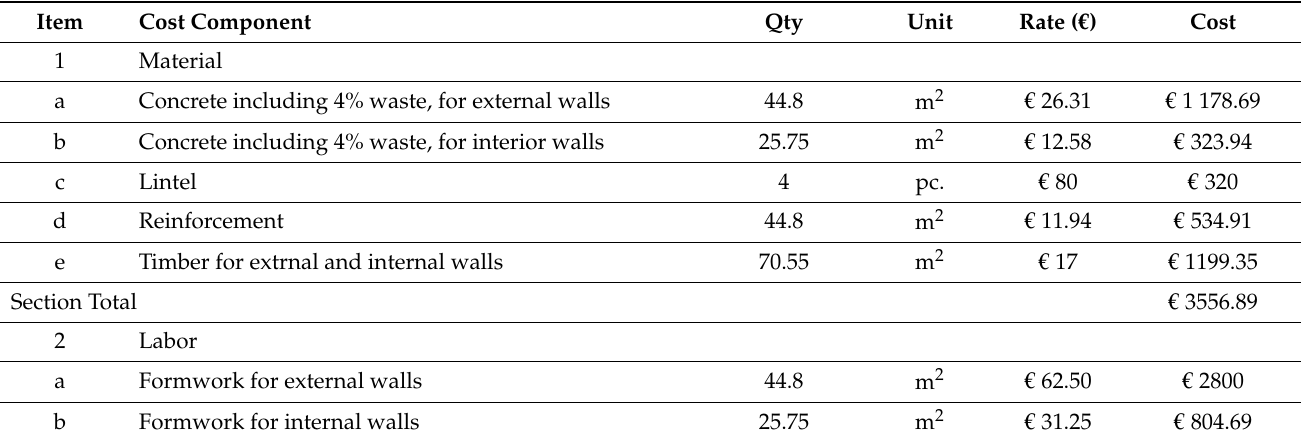
Table A4. Scenario 3 cost model in